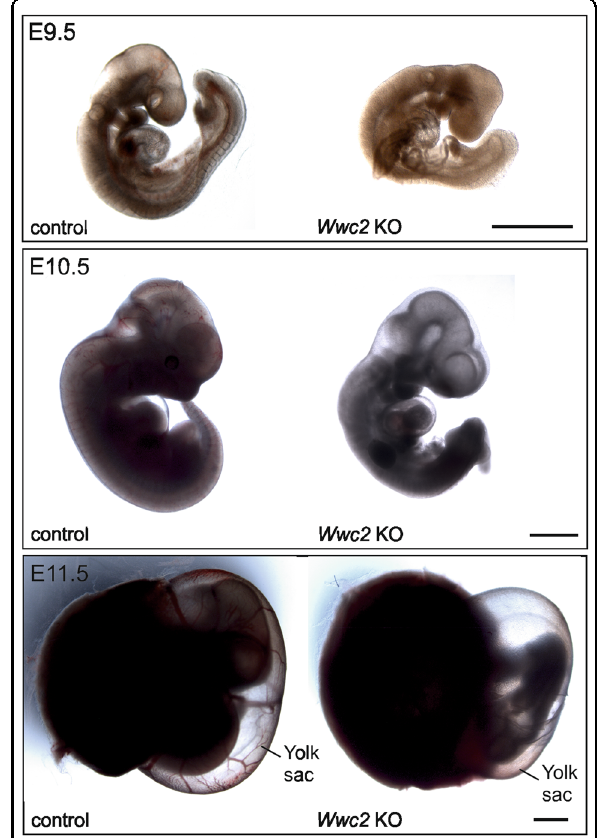
Fig. 3 Growth retardation and disturbed blood fl ow in Wwc2 KO embryos and yolk sacs. Wwc2 KO embryos at E9.5. or E10.5 appeared growth retarded and less developed when compared to control embryo. Furthermore, no blood- fi lled vessels are observed in Wwc2 KO embryos (E10.5) and yolk sacs (E11.5). Scale bars represent 500